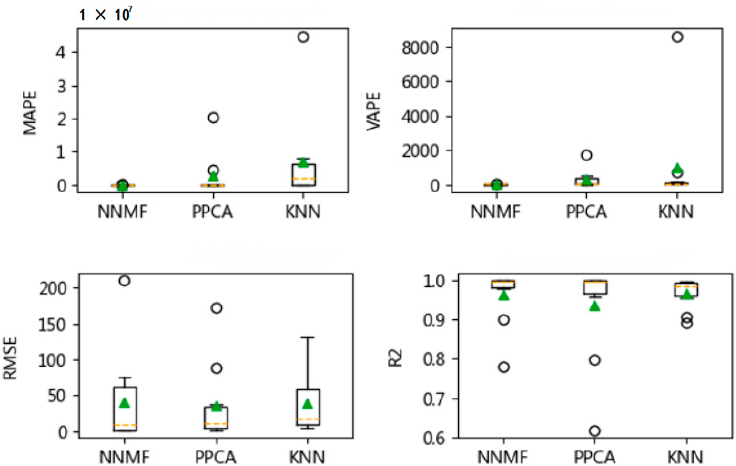
Figure 13. Evaluation results of the data imputation by NNMF, PPCA and KNN for vehicle of ***Y278 under the missing rate of 0.3.